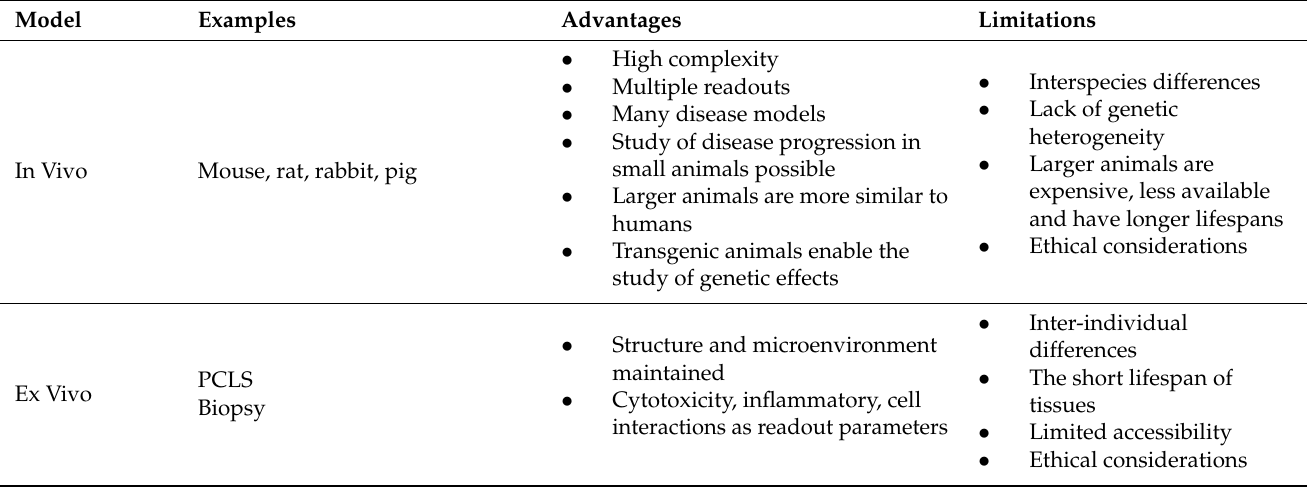
Table 1. Overview of advantages and disadvantages of different models (in vivo, ex vivo, in vitro, in silico). Abbreviations: HPLDB, Hygroscopic Particle Lung Deposition model B; ICRP, international conference on radiation protection; MPPD, multiple path particle dosimetry; PCLS, precision-cut lung